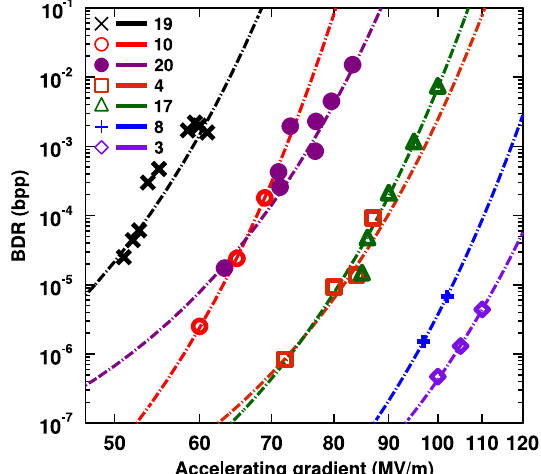
FIG. 2. Measured dependences of breakdown rate R (in units of breakdown per pulse, bpp) versus accelerating for different accelerating structures [8] and fits of gradient E acc the model to the data. The numbers indicate the data sets as defined in Ref.